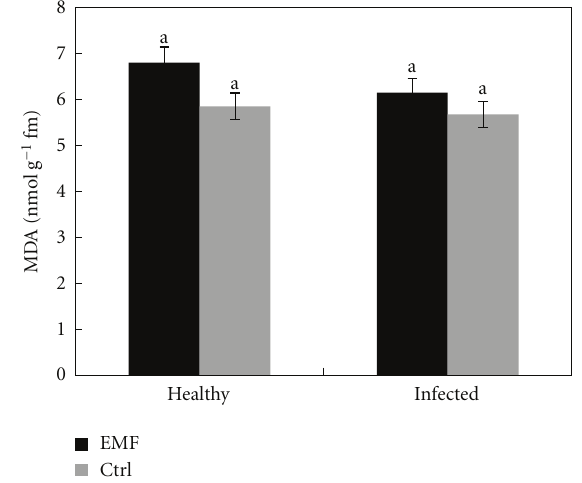
Figure 5: E ff ect of EMF on MDA content in healthy and infected plants of Citrus aurantifolia. Vertical bars indicate mean ± SE of three replicates. Di ff erent letters indicate significant di ff erences ( P < 0 .